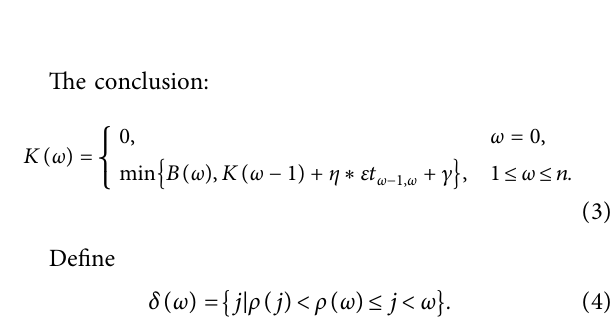
Figure 4: Hadoop platform